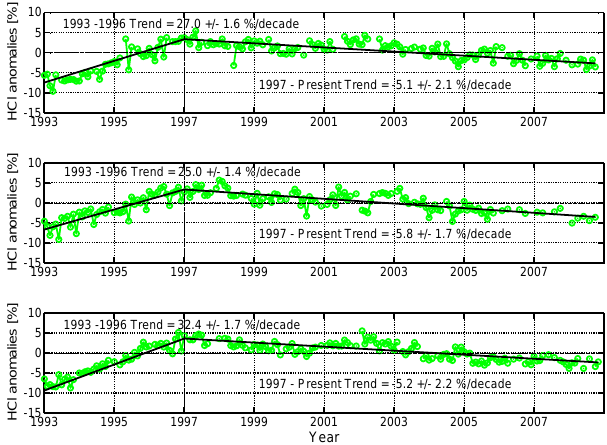
Fig. 7. HCl anomalies for the all instrument average (green) pro- duced from HALOE and ACE-FTS monthly averaged data between 35 and 45km. Top 30 ◦ N–50 ◦ N. Middle, 20 ◦ S–20 ◦ N. Bottom, 30 ◦ S–50 ◦ S. The vertical black dot-dash line at 1997 indicates the turnaround date. The solid black lines indicate the fitted trend to the all instrument average before and after 1997. Trend values are given in %decade − 1 and uncertainties are 2 standard deviations. Please note that the 20 ◦ S–20 ◦ N contains a QBO contribution, while the extra tropical bins have the QBO